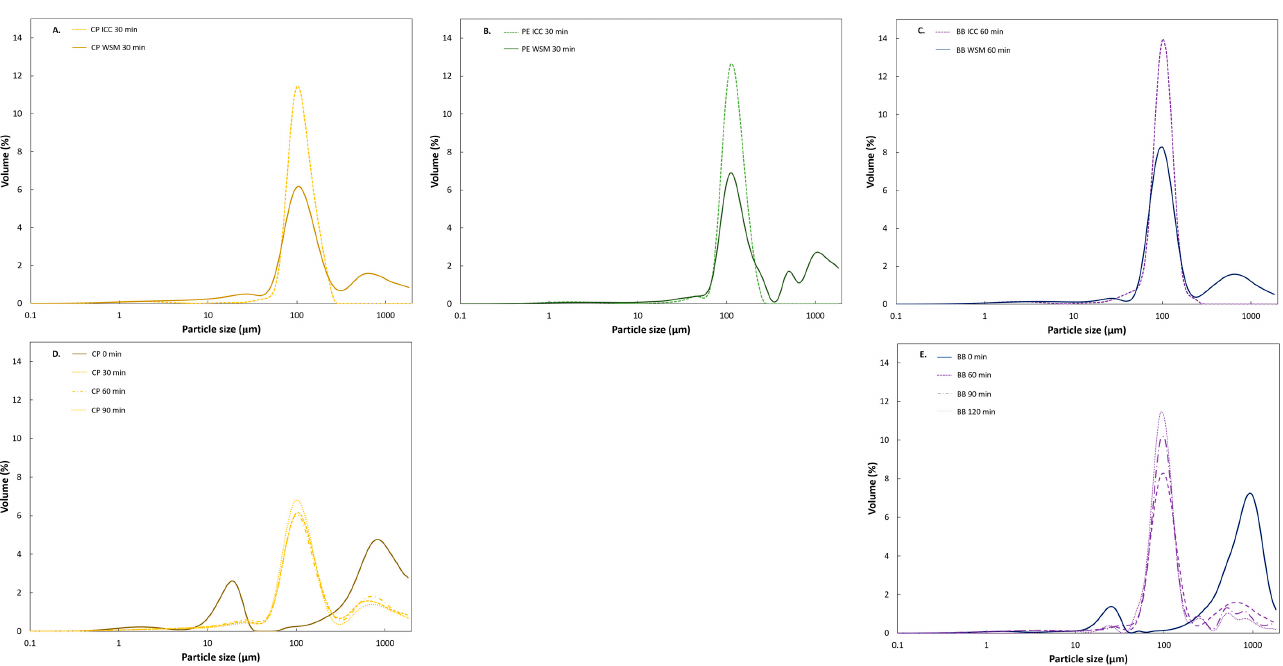
Figure 5. Particle size distribution of hardness-aligned pulses ( A – C ) and pulses subjected to varying hydrothermal processing times ( D , E ). Means of triplicate evaluations are presented. Pulses were hydrothermally processed, followed by mechanical disintegration. For hardness-aligned chickpea (CP) ( • ) ( A ), pea (PE) ( (cid:4) ) ( B ), and black bean (BB) ( (cid:78) ) ( C ) particle size distributions of whole seed material (WSM) and thereof wet-sieved individual cotyledon cell (ICC) fraction are displayed. Particle size distribution of the raw and hydrothermally treated whole seed material for chickpea ( D ) and black bean ( E ) are displayed to study the effect of hydrothermal processing (95 ◦ C for 0, 30, 60, 90, or 120 min) on microstructural and digestive